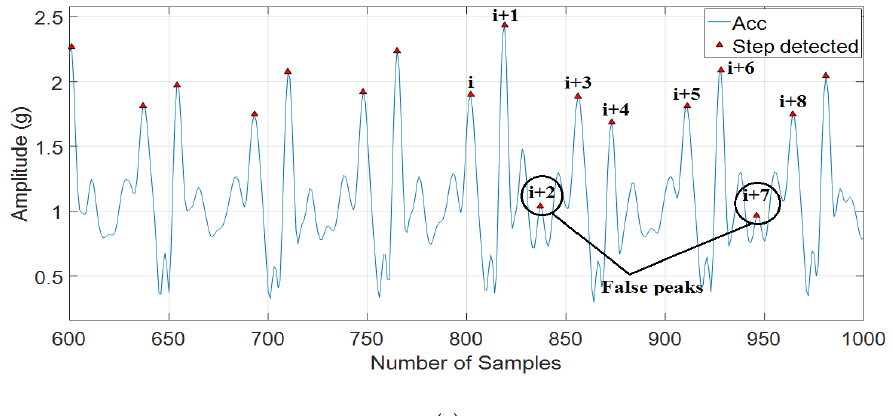
Figure 11. Over-counting problem in step counting based peak detection method [7].